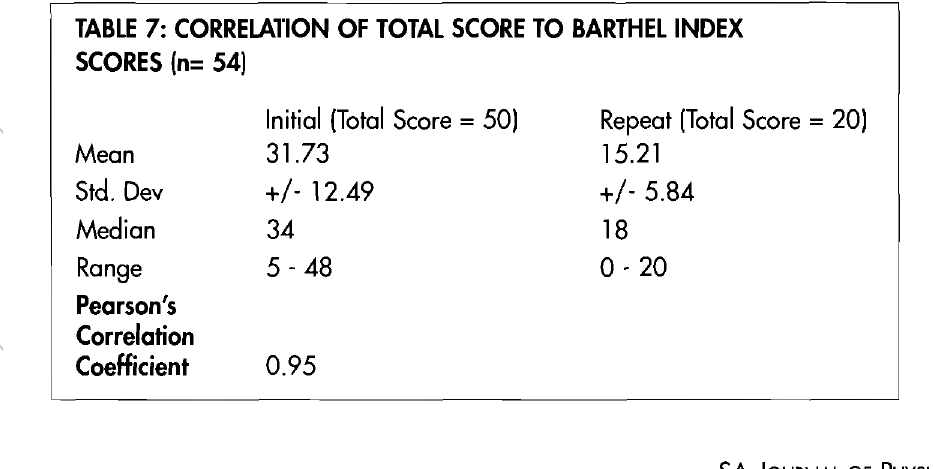
stairs. Walking in different environ­